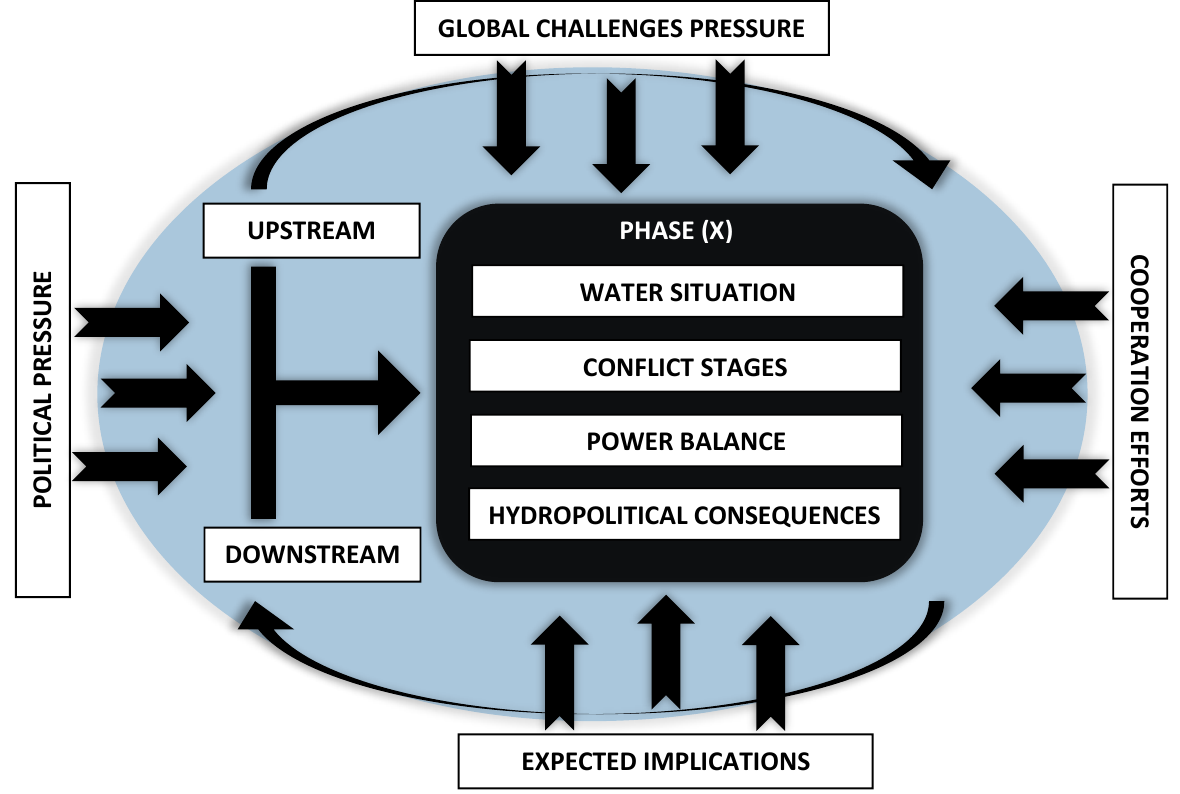
Figure 1. The components of the hydro-politics theory and the framework of spiral escalation of water